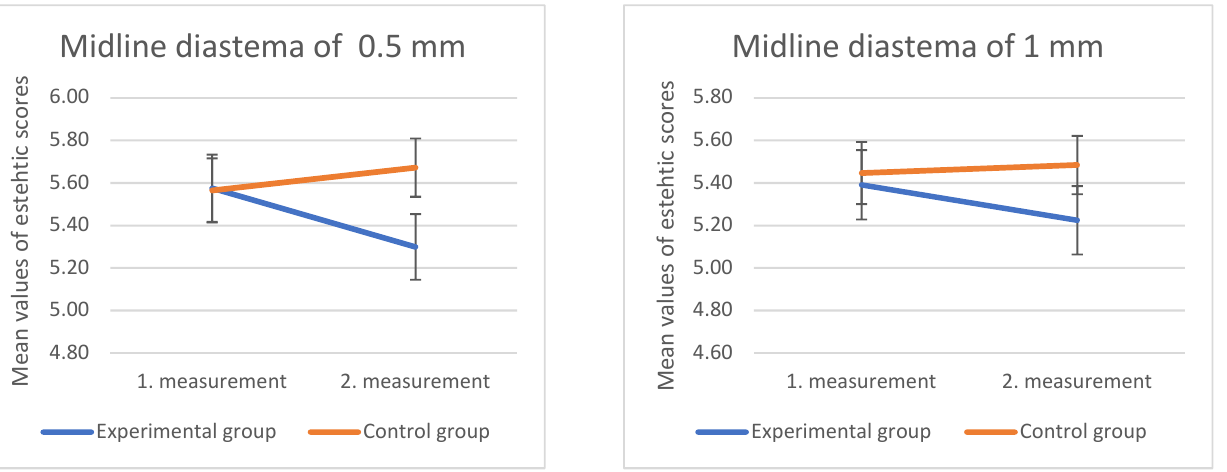
Figure 8. Mean values and standard errors (error bars) of the ratings of the control and experimental groups for images showing a midline diastema of 1 and 3 mm, in the first and second measurements. Self-perception of smile did not differ significantly between control and experimental groups after exposure to social media (Figure 9). In those exposed to Instagram (experimental group), laypeople showed significantly greater satisfaction with their own smile after the exposure to Instagram, whereas no such difference was present in the control group (mean values of the scores of the “laypeople” experimental group pre-exposure = 7.63 ± 1.87, post-exposure = 7.62 ± 1.77) ( p = 0.03).